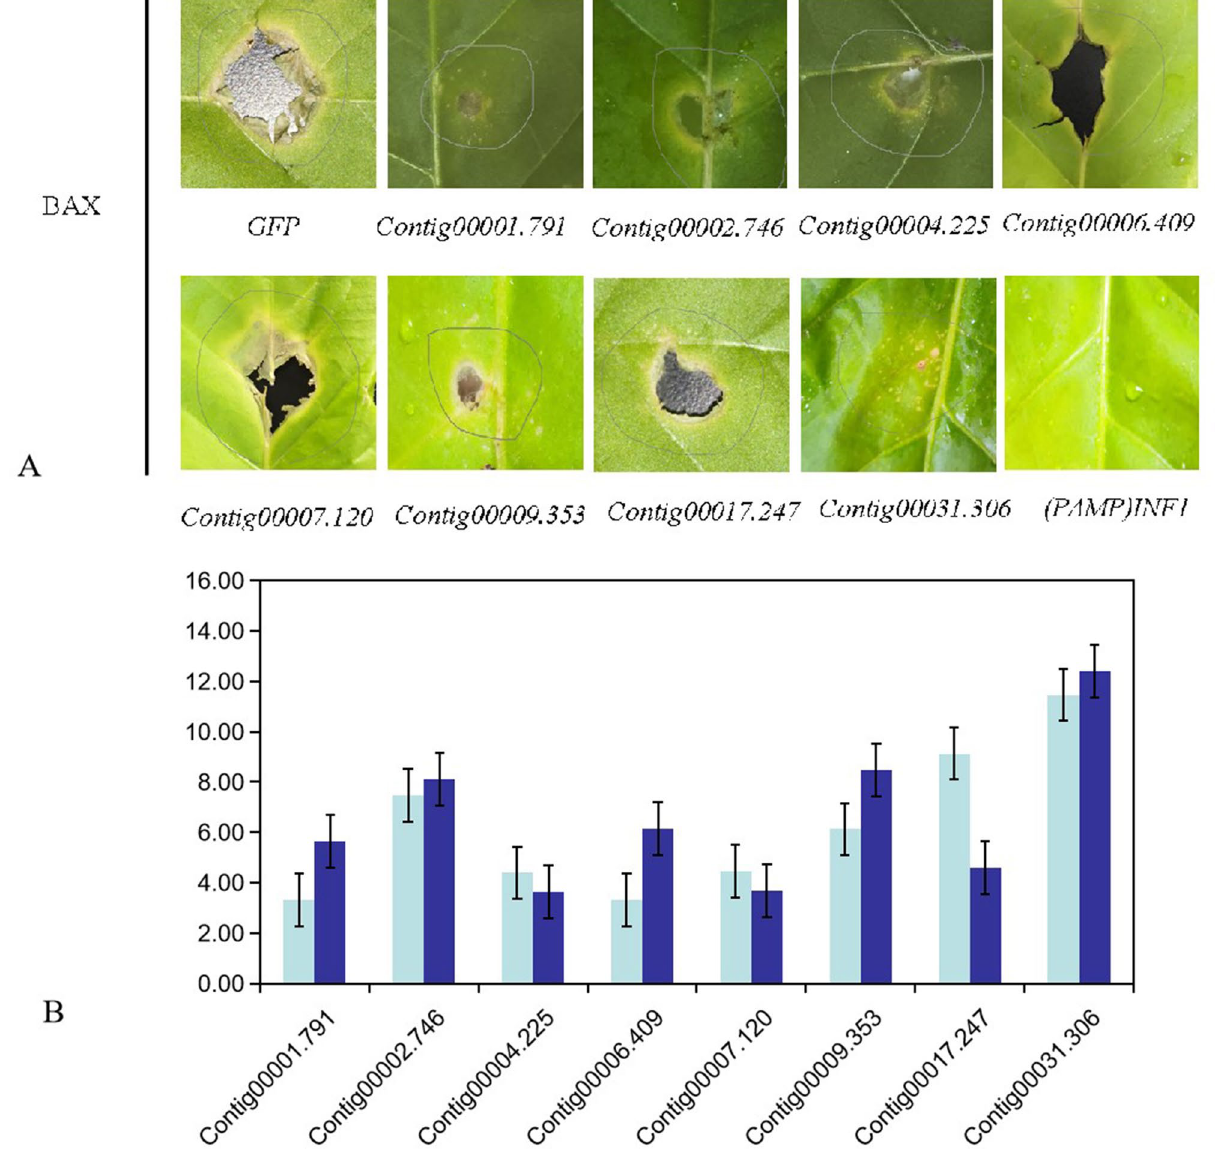
genes. Phytophthora oocytes (infestin-1 or INF1) served as positive controls and GFP as negative control. Pumpkin leaves were inoculated with Sc . Samples were collected at 0 day and 5 days. Quantitative RT-PCR (qRT-PCR) was used to determine gene expression levels. Values represent the mean ± SD (n = 3 biological replicates). The blue and red bars in figure B represent the gene expression at day 0 and day 5 after inoculation,